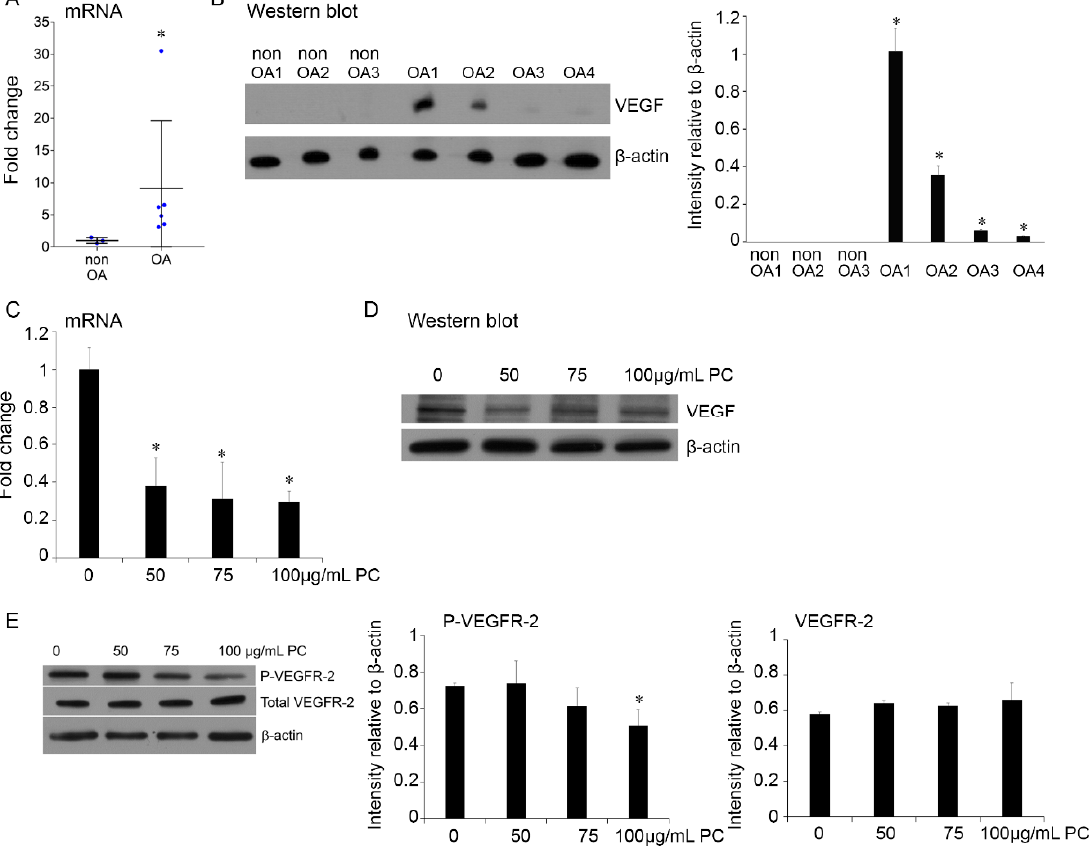
Figure 5. Procyanidins inhibited expression of VEGF and phosphorylation of VEGF receptor-2 in primary human OA chondrocytes. VEGF mRNA expression ( A ) and protein level ( B ) were significantly elevated in primary human OA chondrocytes compared to non-OA chondrocytes. Procyanidins (PC) inhibited VEGF mRNA expression ( C ) and protein expression ( D ) and phosphorylation of vascular endothelial growth factor receptor 2 (P-VEGFR-2) ( E ) in cultured primary human chondrocytes in the presence of human recombinant IL-1 β (10 ng/mL). Western blot and quantifications of three representative Western blots are shown. * p < 0.05 vs. controls, one-way ANOVA with Tukey post hoc test.